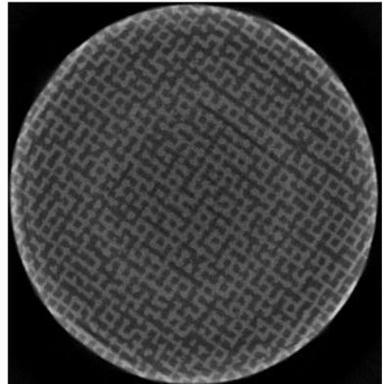
Specimen 300: Voxel model after segmentation.